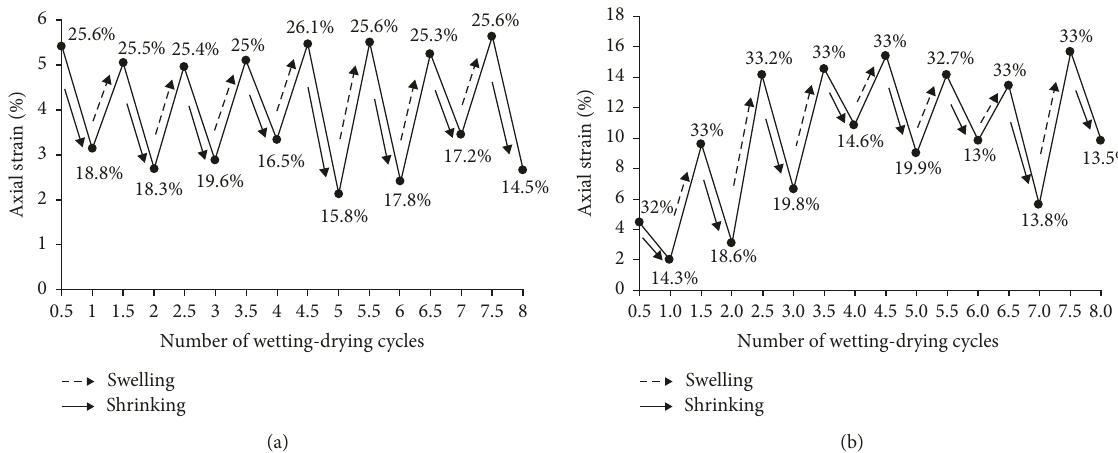
Figure 9: Axial deformations during swelling-shrinking cycles: (a) the stabilized soil sample; (b) the natural expansive soil sample.